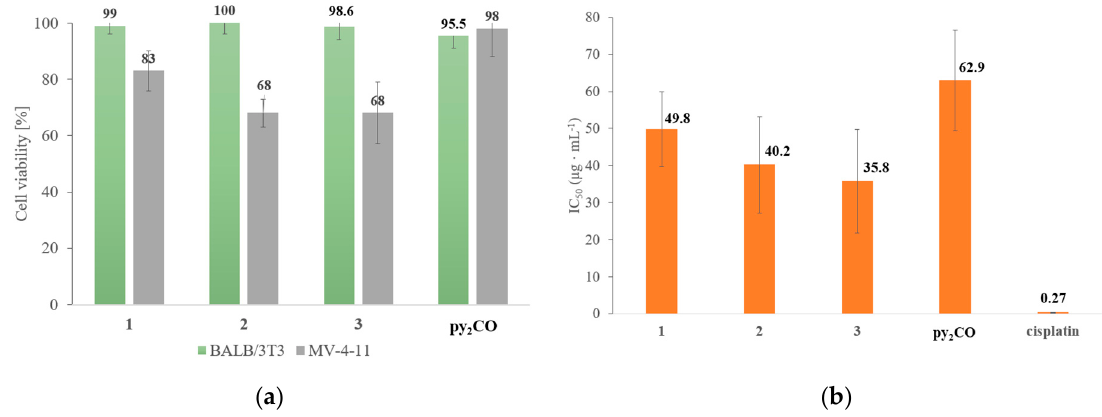
Figure 9. Effect of complexes 1 - 3 and free py 2 CO on viability of normal cell line BALB/3T3 and cancer cell line MV-4-11 ( a ), IC 50 values of the analyzed compounds and cisplatin against MV-4-11 ( b ).